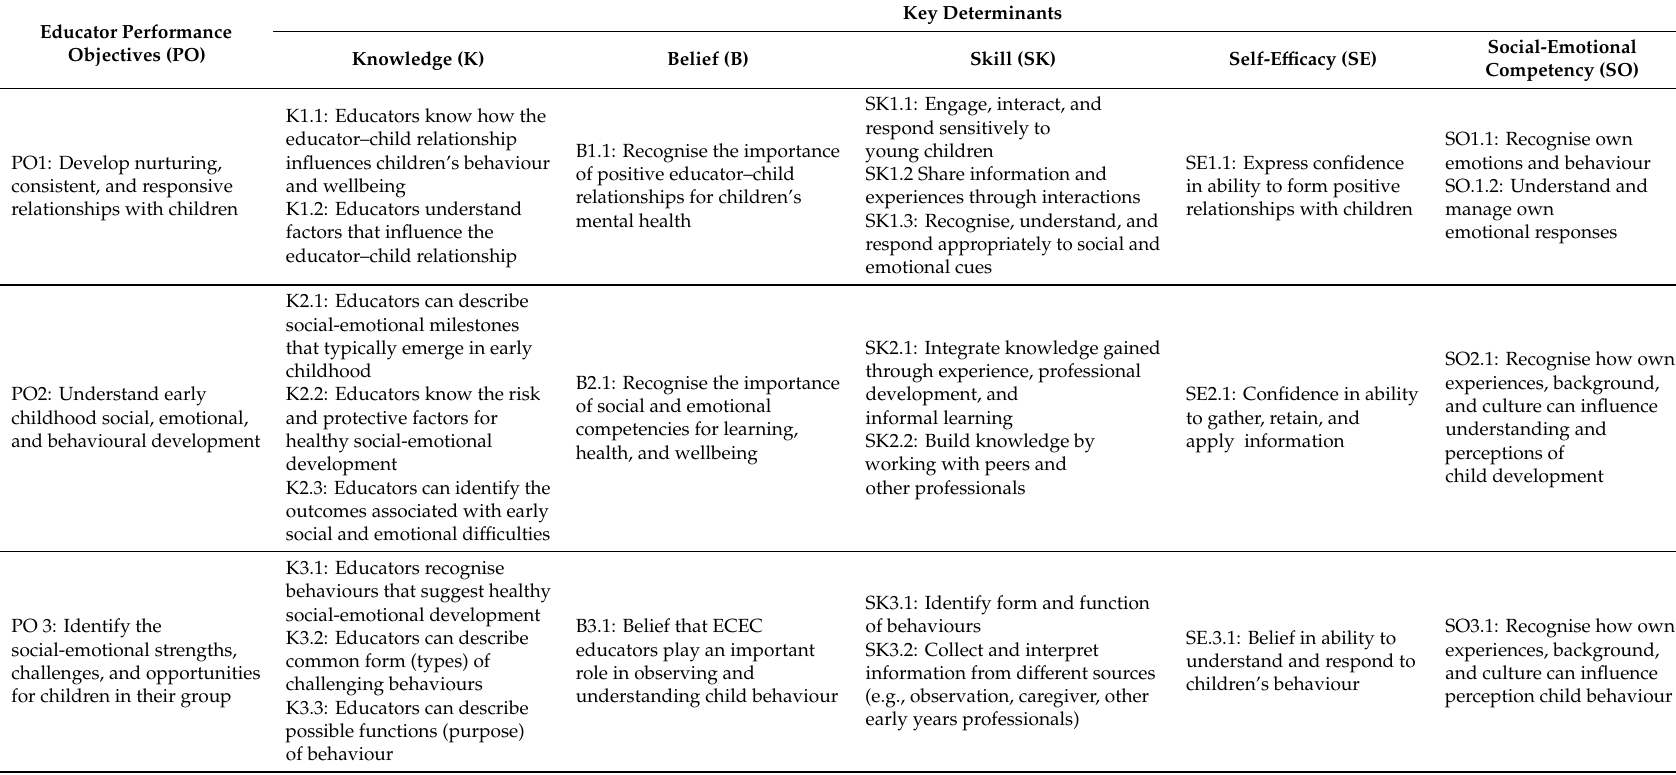
Table 3. Matrix of Change Objectives for Educators (Individual